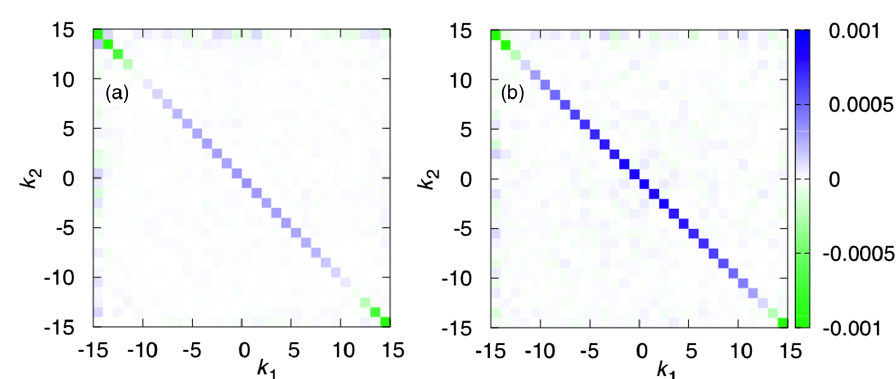
a ϵ ¼ 0 . 0089 , (b) ϵ ¼ 1 . 12 . A diagonal contribution k 2 i(cid:4) , for (a) 1